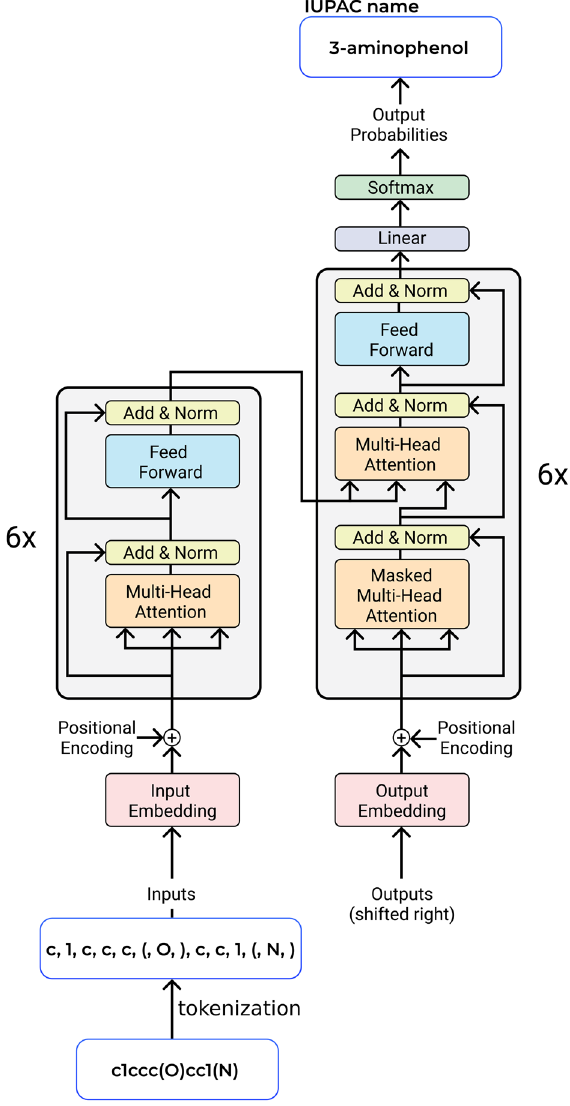
Figure 2. A scheme of Struct2IUPAC Transformer. Adopted from 6